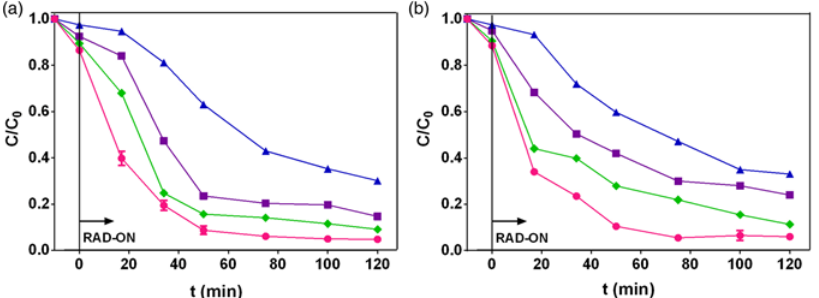
Figure 3. Ciprofloxacin degradation (C 0 = 100 µ g L − 1 ) by ( a ) P25 (100 mg L − 1 ) and ( b ) PC500 (50 mg L − 1 ) in di ff erent water matrices. Ultrapure ( • ), simulated ( (cid:7) ), bottled ( (cid:4) ) and tap water ( (cid:78) ). Reprinted with permission from [59], copyright 2018, IWA.